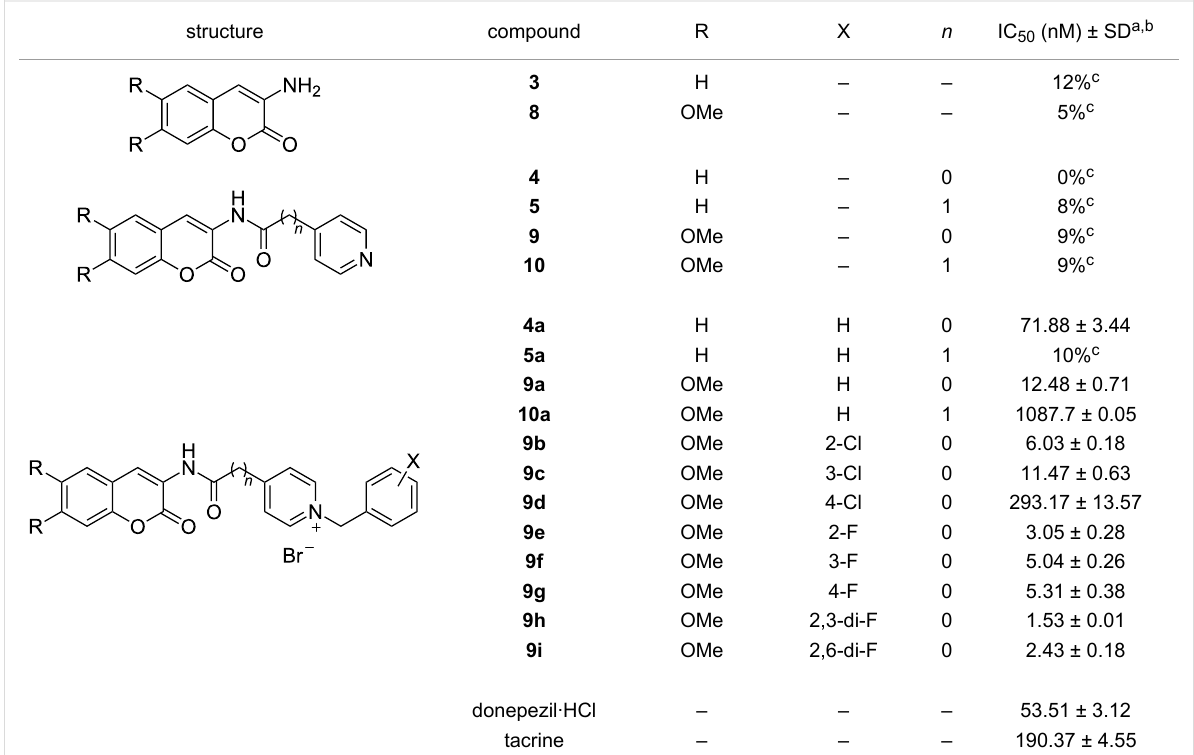
Table 1: Acetylcholinesterase inhibitory activity of 3-aminocoumarin